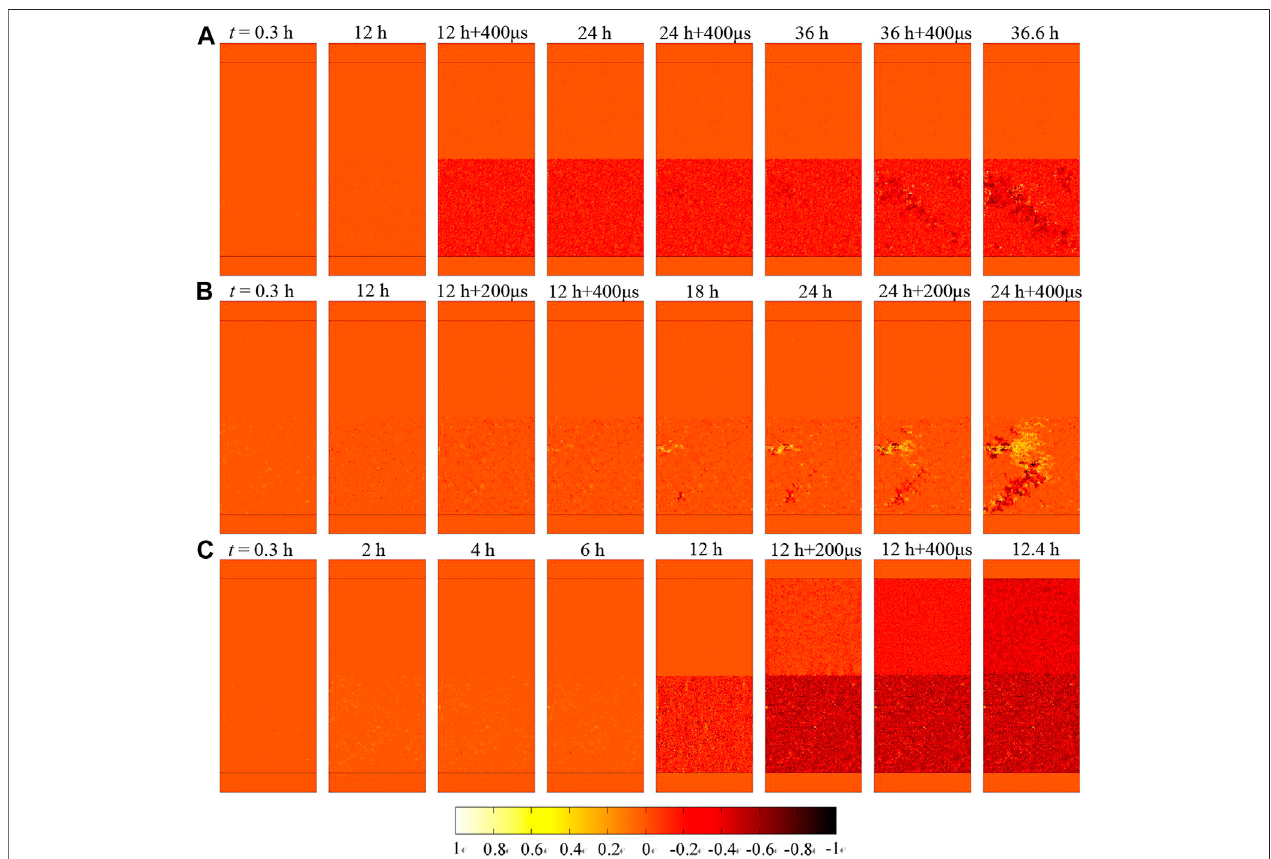
FIGURE 5 | Numerical results of damage distribution under multi-stage creep test with dynamic disturbance: (A) creep stress = 15.18 MPa and impact high = 30 cm, (B) creep stress = 17.71 MPa and impact high = 30 cm, (C) creep stress = 20.24 MPa and impact high = 30 cm.